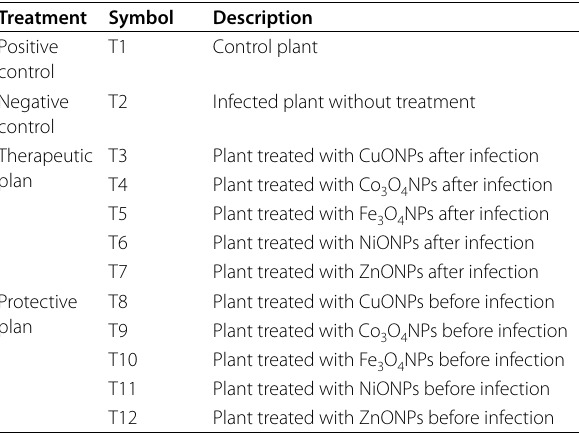
Texture Table 2 Treatment plans, symbols, and their description used against Fusarium wilt disease Treatment